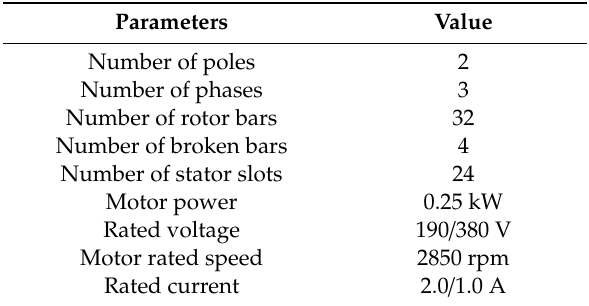
Table 1. The detailed parameters of the Induction Motor